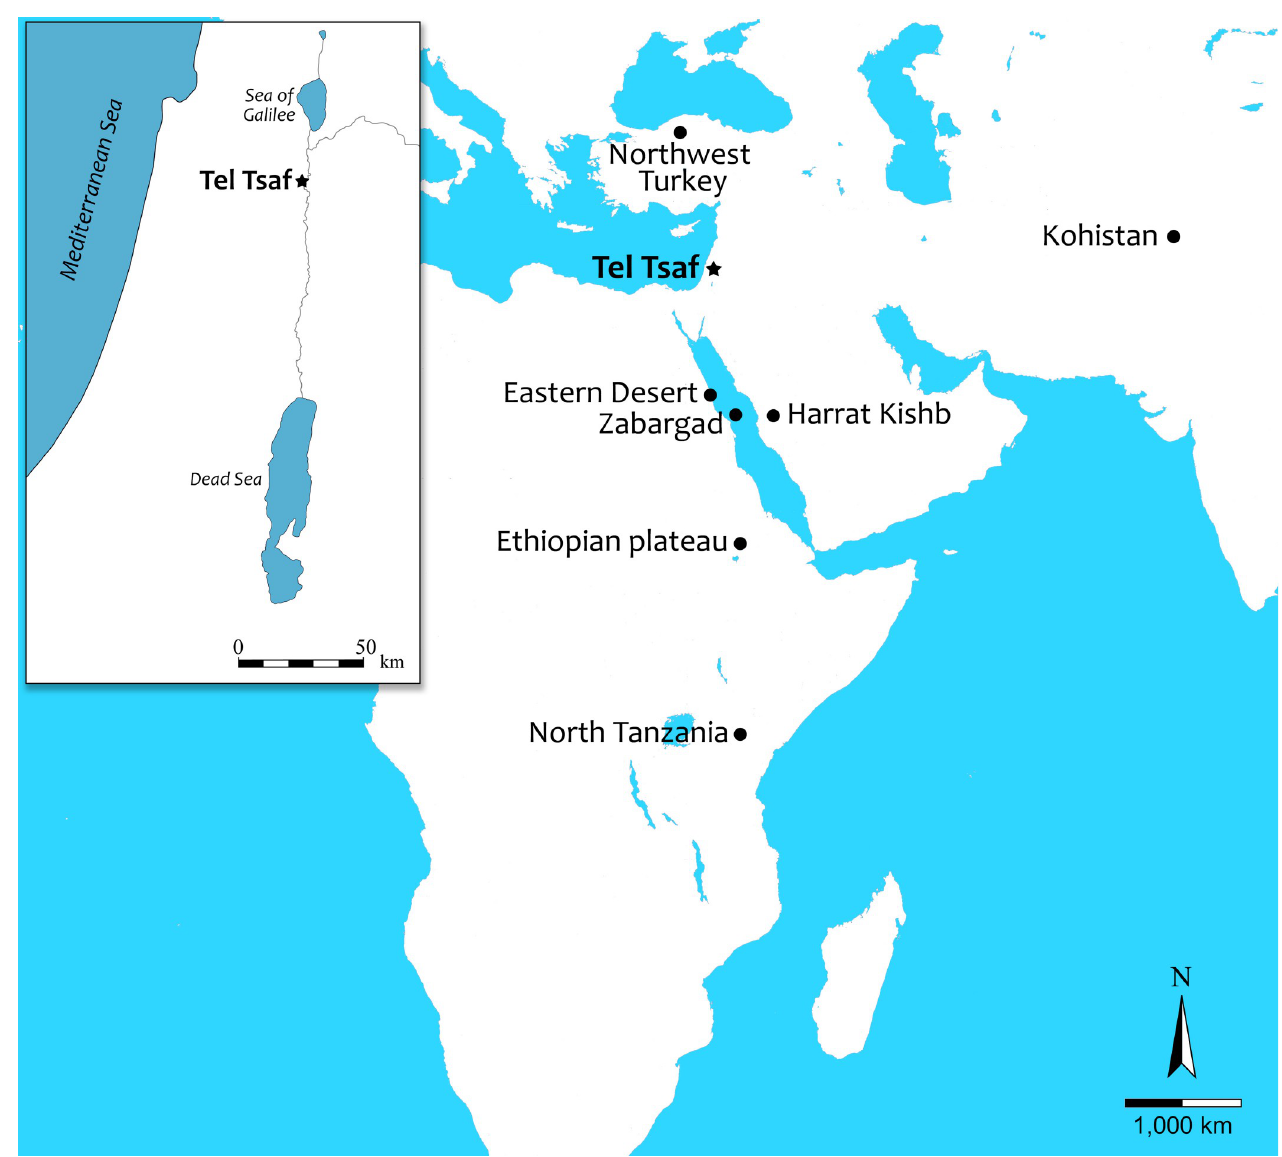
Fig 1. A map of the Near East and Africa with the locations of potential olivine sources (created by S. Haad).